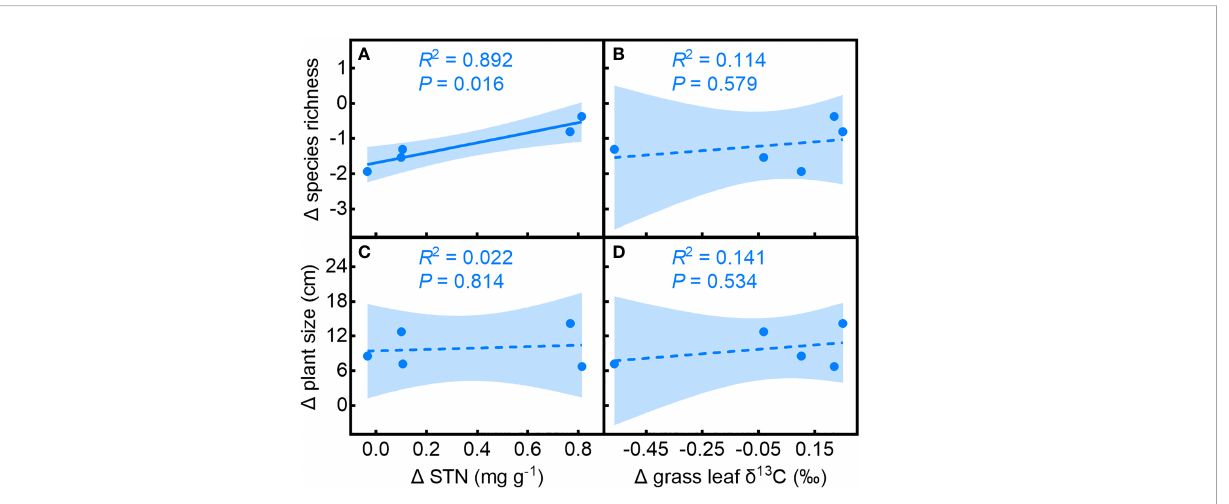
FIGURE 5 Relationships of the effects of Caragana versicolor on (A, B) species richness ( D species richness) and (C, D) plant size ( D plant size) to the effect on soil N ( D soil N) and grass leaf d 13 C ( D grass leaf d 13 C) in drylands of Tibetan